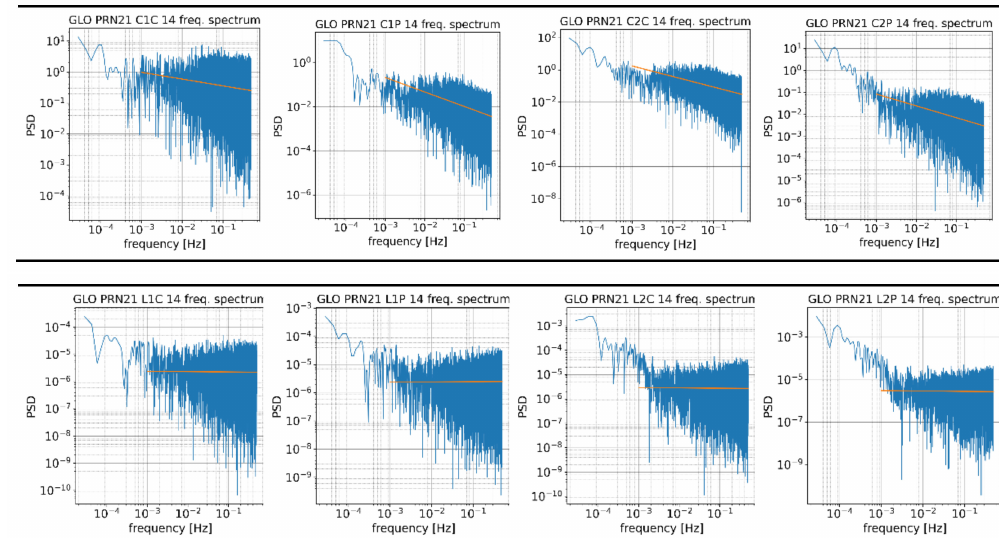
Figure 9. Lomb–Scargle periodograms for the GLONASS PRN21 satellite. Orange lines represent the line fitted in the part of the spectrum in the of range 0.001–0.5 Hz. The slope of the line represents the spectral index value.